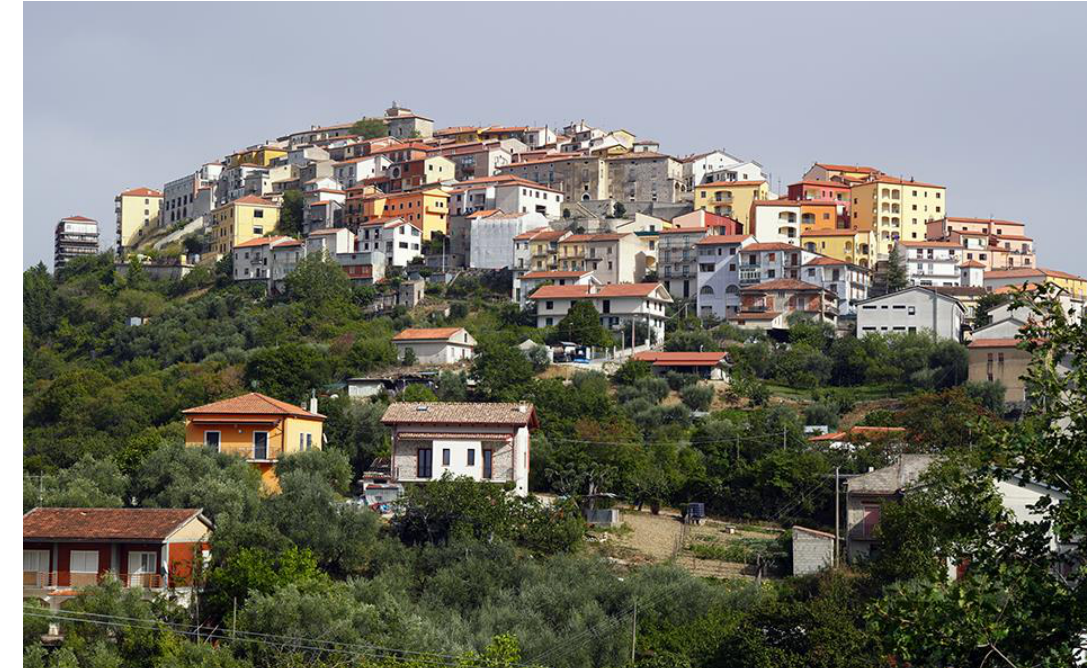
Geosciences 2021 , 11 , x FOR PEER REVIEW Figure 90. Salvitelle: Panoramic view of the new village (photos by [35,36]). Figure 90. Salvitelle: Panoramic view of the new village (photos by [35,36]).